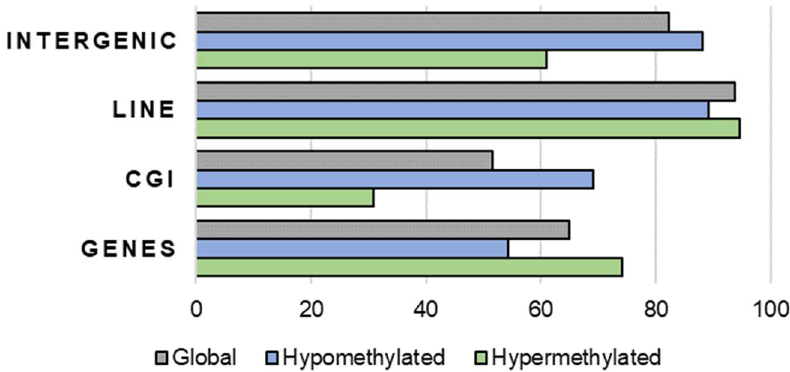
Figure 1. Proportions of different genomic features overlapping DNA hypermethylated (colour green) and hypomethylated (colour blue) tiles in cow oocytes compared to the whole genome (global, colour grey).